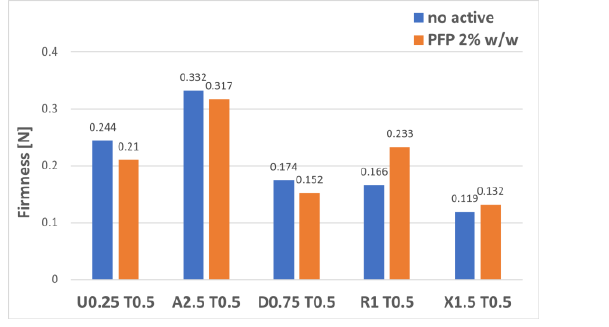
10 Figure 2. Comparison between the rheological parameters measured before and after adding 2% w / w of PFP for the gels U0.25T0.5 prepared with U at 0.25% w / w and T at 0.5%, A2.5T0.5 prepared with A at 2.5% w / w and T at 0.5% w / w , D0.75T0.5 prepared with D at 0.75% w / w and T at 0.5% w / w , R1T0.5 prepared with R at 1% w / w and T at 0.5% w / w , X1.5T0.5 prepared with X at 1.5% w / w and T at 0.5% w / w : ( a ) complex modulus G* and ( b ) damping factors tan δ calculated at 1.5 Hz. This behavior was confirmed with the texture analyses performed on the gel formu- lations before and after the insertion of PFP in the formulation (Figure 3). The samples containing the polymers A and U showed the highest values of firmness, whereas the sample containing the polymer X showed the lowest values (Figure 3a). This texture pa-